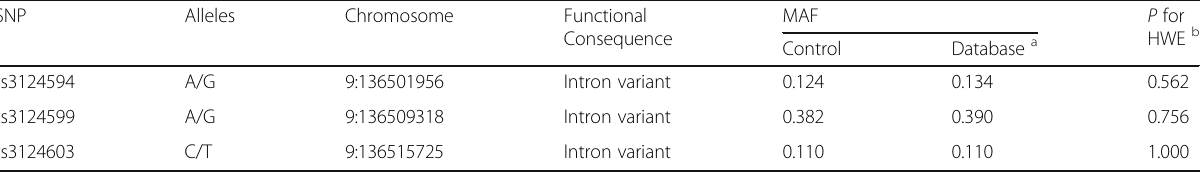
MAF P for Consequence HWE b Control Database a